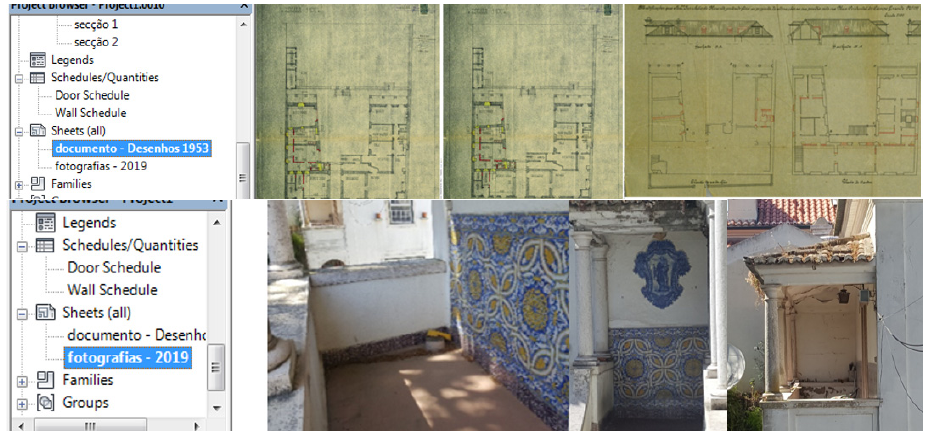
Figure 34. ( a ) The lateral upper floor was replaced by a composite slab. ( b ) Model with the new structure.